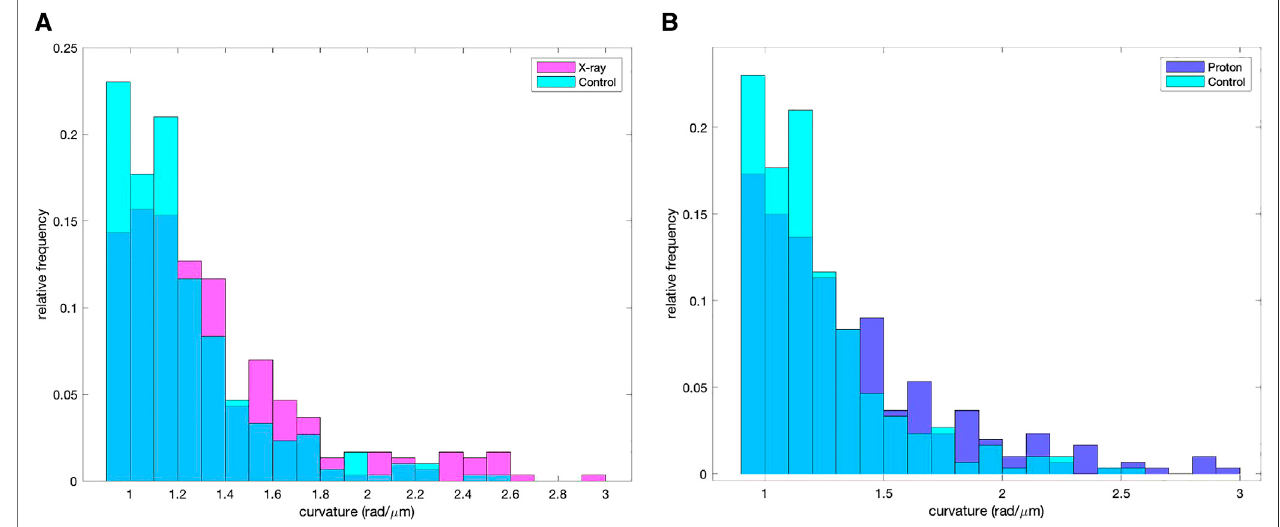
FIGURE 6 | Pixelwise curvature distribution of the reconstructed MTs for pixelwise curvature values > 0.92 rad/ μ m. (A) Control and proton-irradiated samples, (B) control and X-ray irradiated samples.